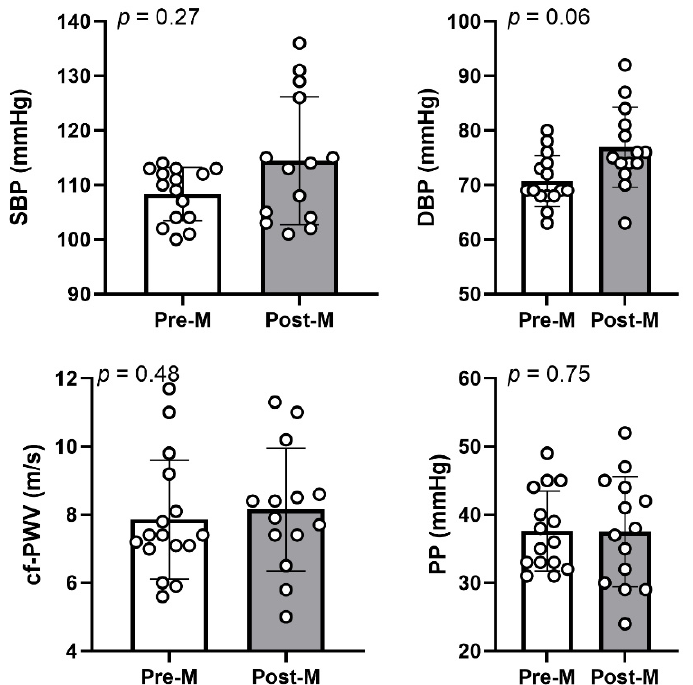
Figure 1. Blood pressure and central stiffness assessed in physically active pre- (Pre-M, white) and post- (Post-M, grey) menopausal females : SBP, systolic blood pressure (top left panel); DBP, diastolic blood pressure (top right panel); cf-PWV, carotid-femoral pulse wave velocity (bottom left panel); PP, pulse pressure (bottom right panel). Data are presented as mean ± SD with individual values for 16 pre- and 14 post-menopausal females. p value is for an ANCOVA with age as a covariate.